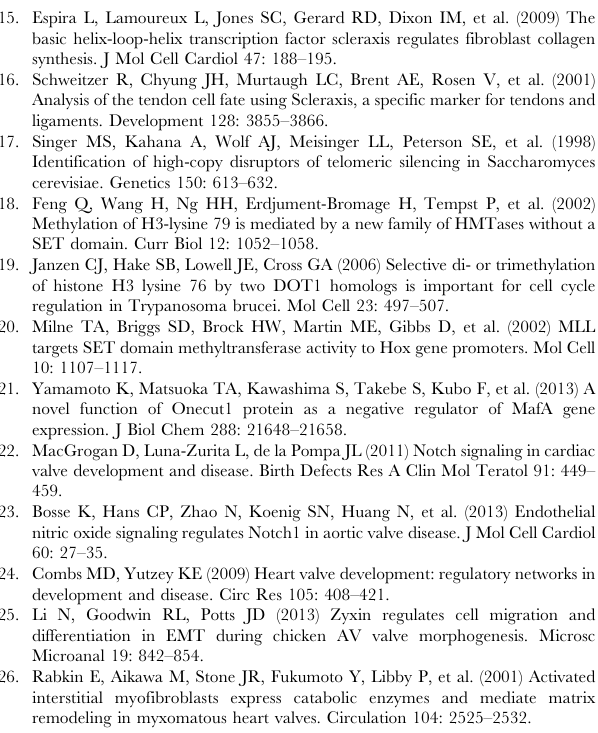
Table S1 Differentially expressed non-protein coding tricular canal samples compared to Scx + / + controls. Table S2 Exon-level alternative splicing in atrioventric- ular canal regions isolated from E15.5 Scx -/- vs. Scx + / +